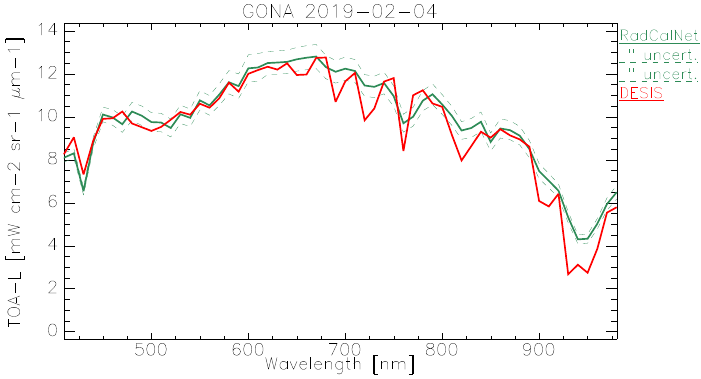
Figure 12. Comparison of RadCalNet TOA-L to DESIS mean TOA-L for RadCalNet location, GONA, 4 February 2019, resampled to RadCalNet spectral